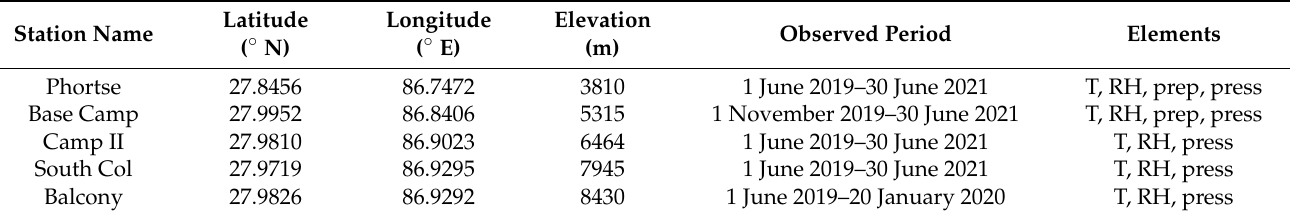
Table 1. The detailed information about the AWSs used in this